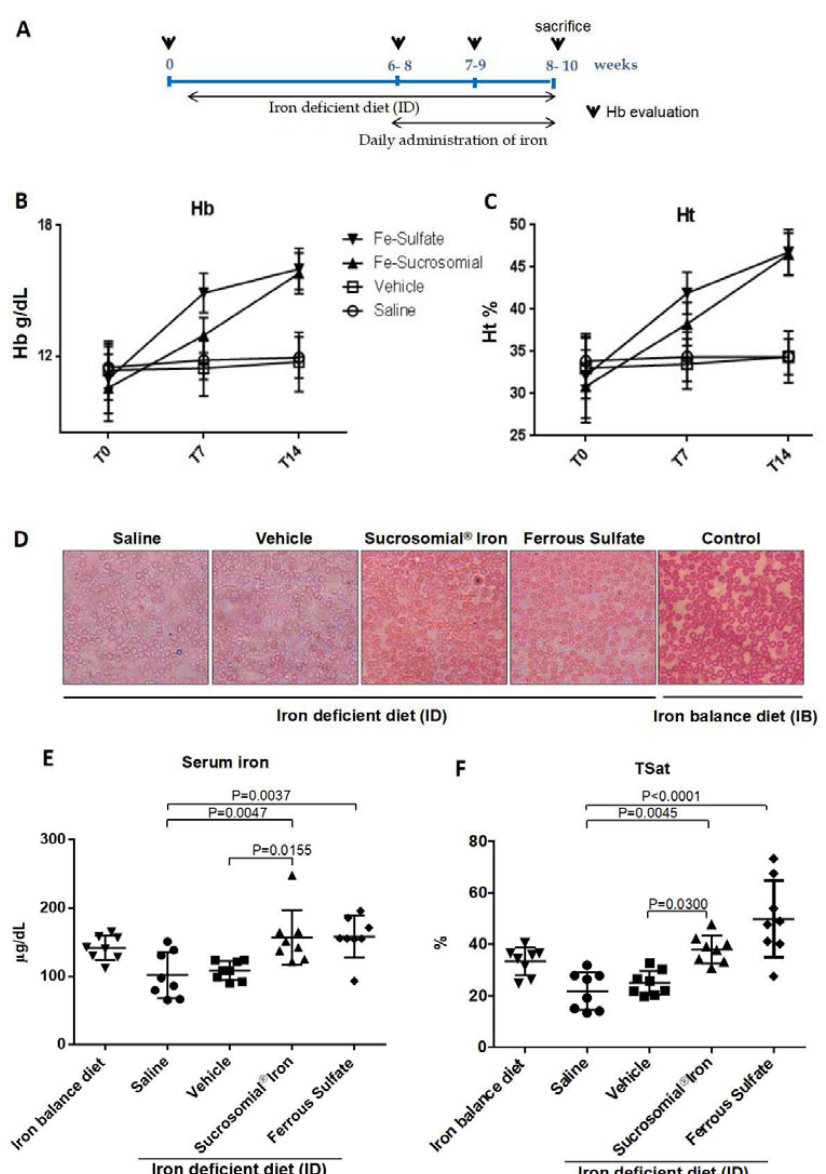
Figure 2. Sucrosomial ® Iron and Ferrous Sulfate treatment of anemic mice rescued the anemia. ( A ) Scheme of the treatment protocol: healthy mice were maintained for 6–8 weeks in iron free-diet to reach hemoglobin level <12 g/dL, then in presence of iron free diet they were treated daily with Saline, Vehicle, Sucrosomial ® Iron and Ferrous Sulfate (1 mg/kg) by gavage for 2 weeks. ( B ) Hemoglobin and ( C ) hematocrit level in mice after the treatments; ( D ) Representative image of peripheral blood smear (May–Grünwald staining) of treated mice (Saline, Vehicle, Sucrosomial ® Iron, Ferrous Sulfate) in presence of iron-free diet (ID) compared to healthy mice (on the right, control mouse) maintained in iron-balanced diet (IB). ( E ) Serum iron content. ( F ) Transferrin saturation (TSat) content in the four treated groups. In E and F Saline (circles), Vehicle (squares), Sucrosomial ® Iron (triangles), Ferrous Sulfate (diamonds) and iron balance group (inverted triangles). p values were obtained by one-way ANOVA comparing Sucrosomial ® Iron and ferrous sulfate versus saline and vehicle.